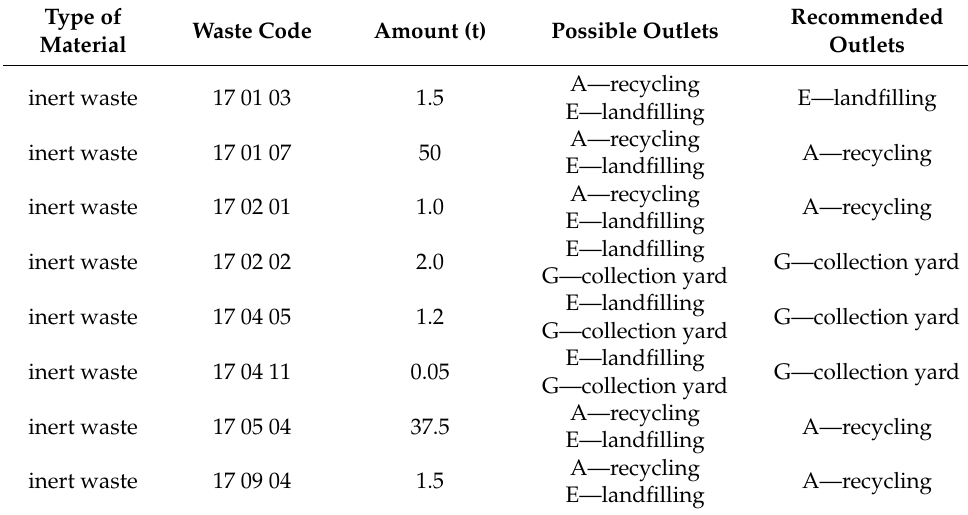
Table 9. Waste management recommendations.